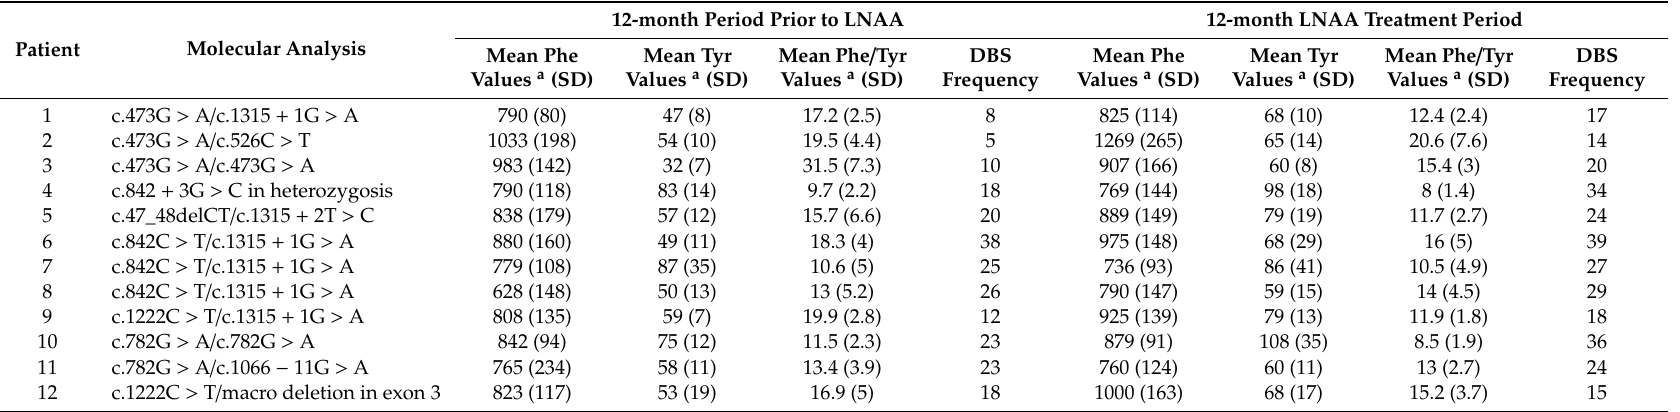
Table 4. Molecular analysis of each patient and the mean (SD) values of Phe, Tyr, Phe / Tyr ratio, and DBS frequency over the 12-month period prior to the introduction of LNAA and over the 12-month LNAA treatment